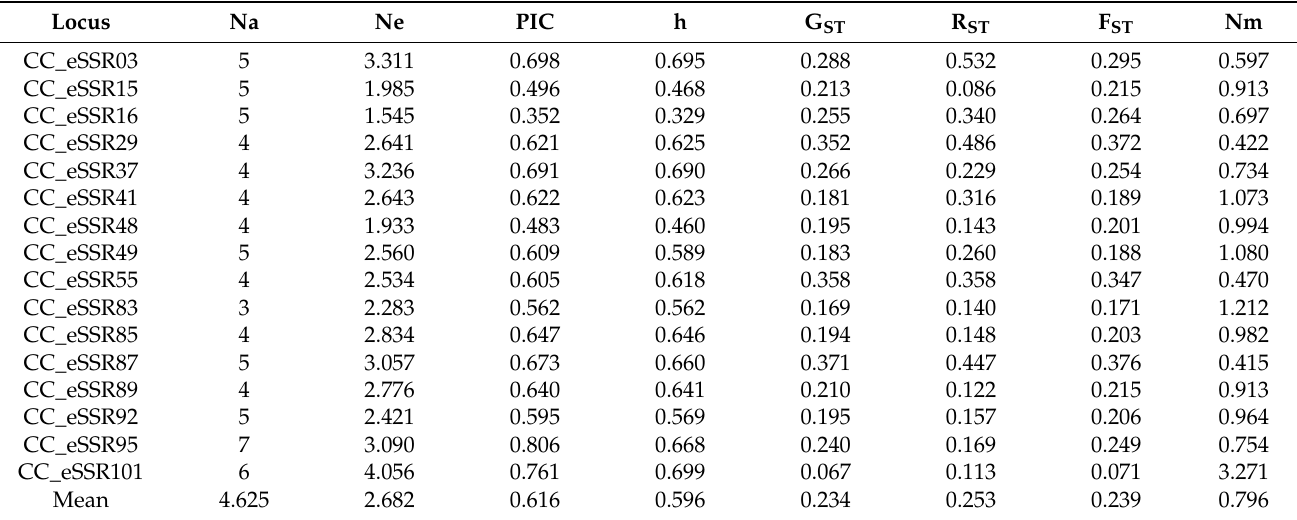
Table 1. Information on the polymorphism of 16 microsatellite loci amplified in C. chekiangoleosa